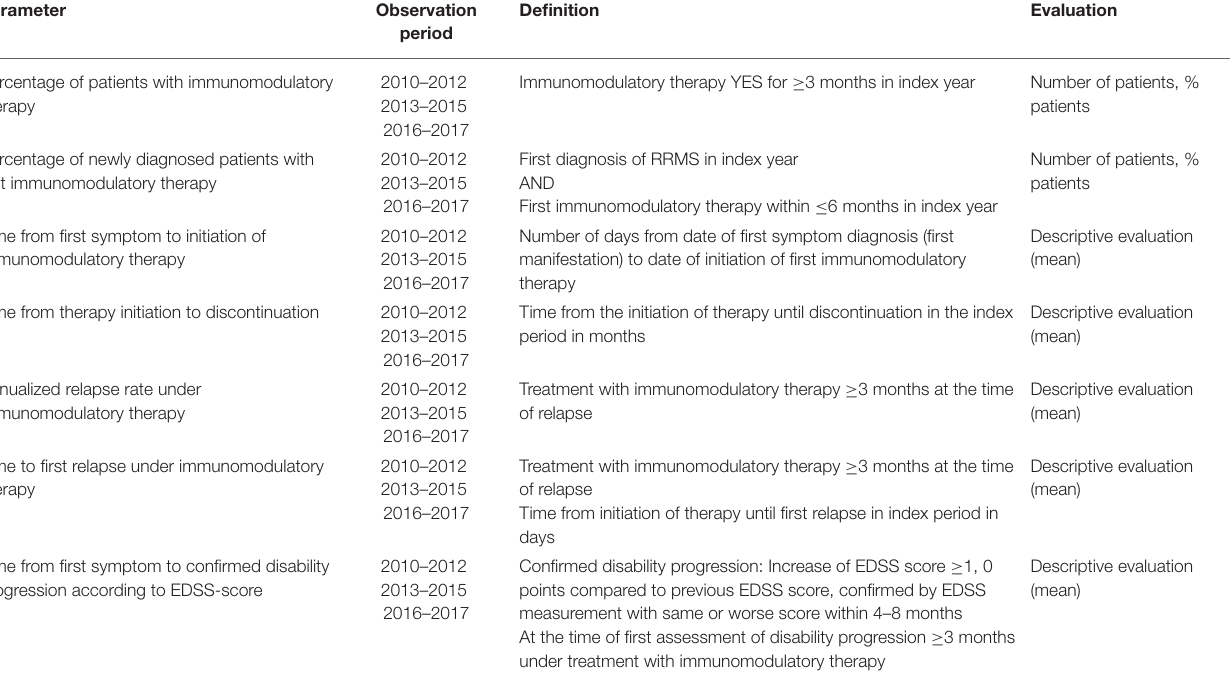
TABLE 3 | Statistical analysis